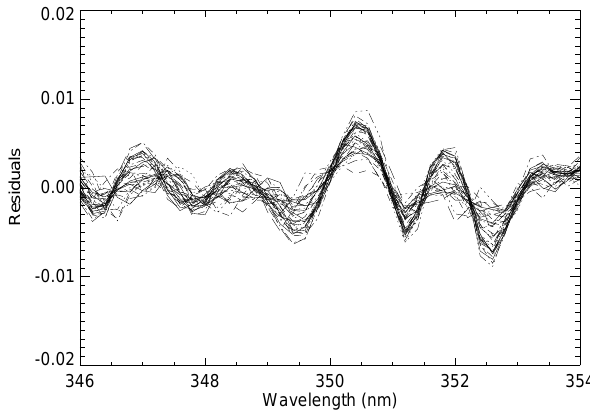
Figure 3. Spectral residuals/corrections that are applied to mea- sured TOA OMPS radiances as derived from data over Antarctica. Fig. 3. Spectral residuals/corrections that are applied to measured TOA OMPS radiances as derived from data Each curve is for a particular OMPS cross-track over Antarctica. Each curve is for a particular OMPS scan position.